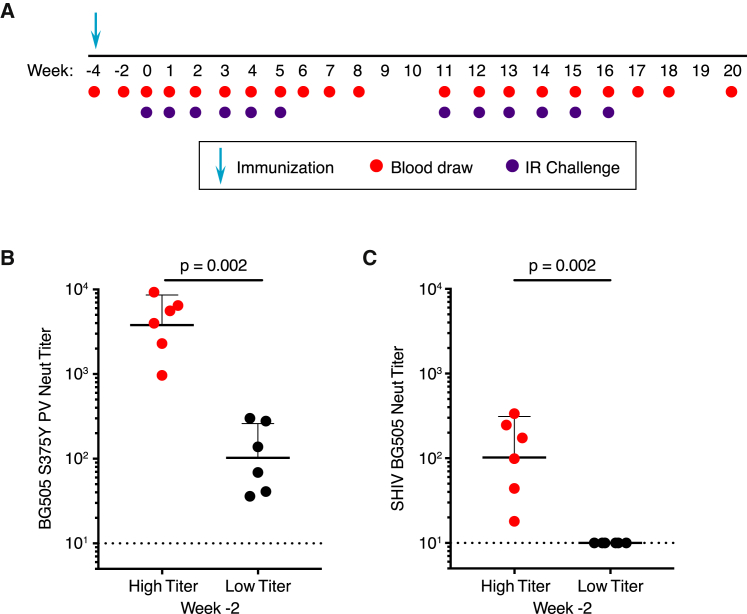
High and Low nAb Titer Group Animals Have Significantly Different Serum nAb Titers after Env Trimer Immunization(A) Animals, except for the controls, received a booster immunization using the same immunogen that had last been used during the preceding immunization study (Pauthner et al., 2017), typically 100 μg SOSIP trimer adjuvanted in a soluble ISCOMs-class saponin. Intrarectal (IR) challenges with SHIVBG505 S375Y commenced 4 weeks thereafter. All groups of animals received six IR challenges starting at week 0. High nAb titer animals that had undetectable serum viral loads at week 6 received a second set of 6 weekly IR challenges starting week 11.(B and C) Serum neutralizing ID50 titers in high and low nAb titer animals at week −2: BG505 S375Y pseudovirus (B) and rhCD4+ T-cell-grown SHIVBG505 S375Y challenge stock. (C) Shown are geometric mean titers with geometric standard deviations, significant differences were determined using two-tailed Mann-Whitney U tests.See also Figure S1.